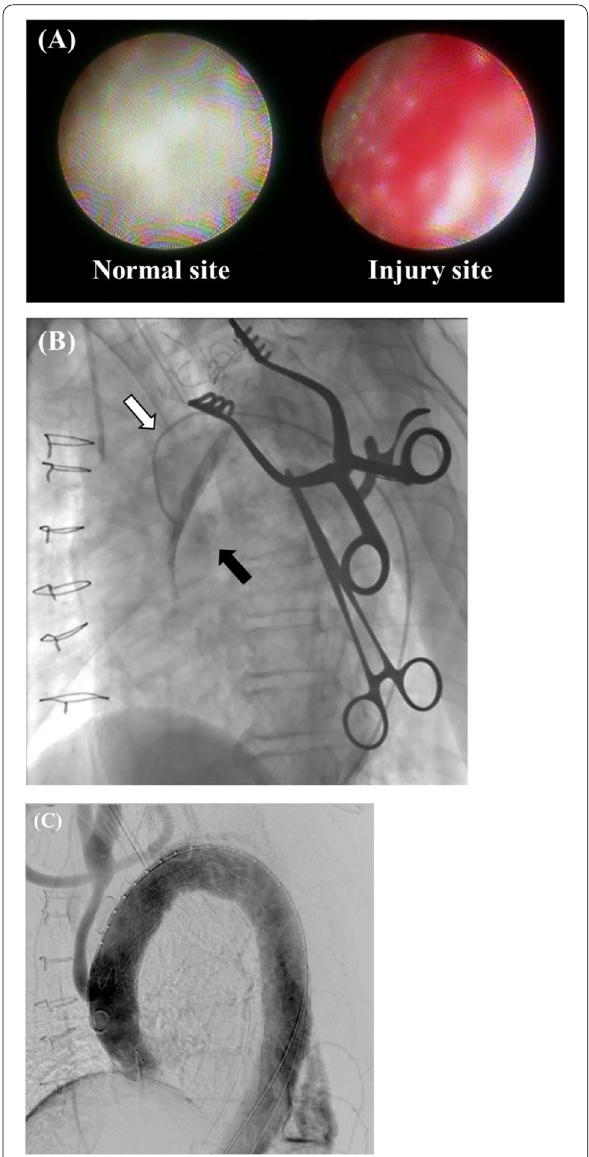
Fig. 2 Intraoperative aortic angiography and aortoscopic findings. Aortic angioscopy shows a red graft rupture site ( A ) that matches the pooling of contrast medium (black arrow) observed on simultaneous angiography using a non-obstructive angioscopy system (white arrow) at the contralateral level of the left common carotid artery branch contralateral level ( B ). Post-deployment angiography shows no extravasation ( C )